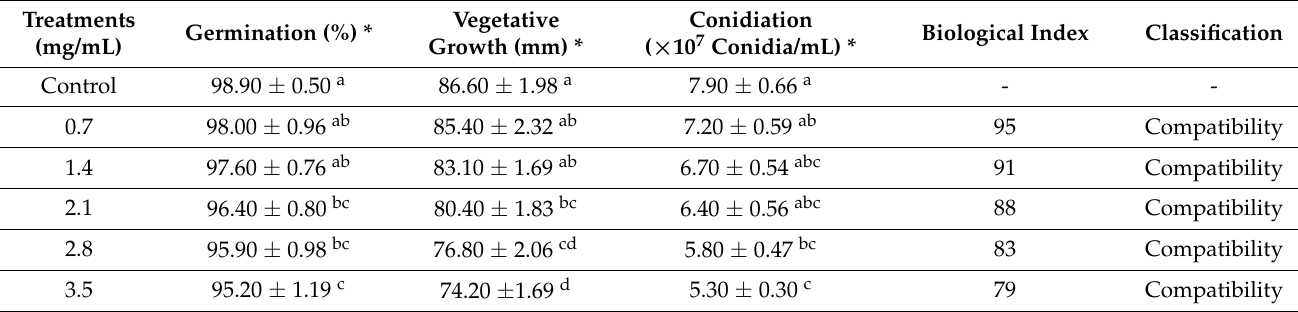
Table 3. Biological Index of B. bassiana ARSEF 8465 calculated from various growth parameters in response to different concentrations of (+)- α